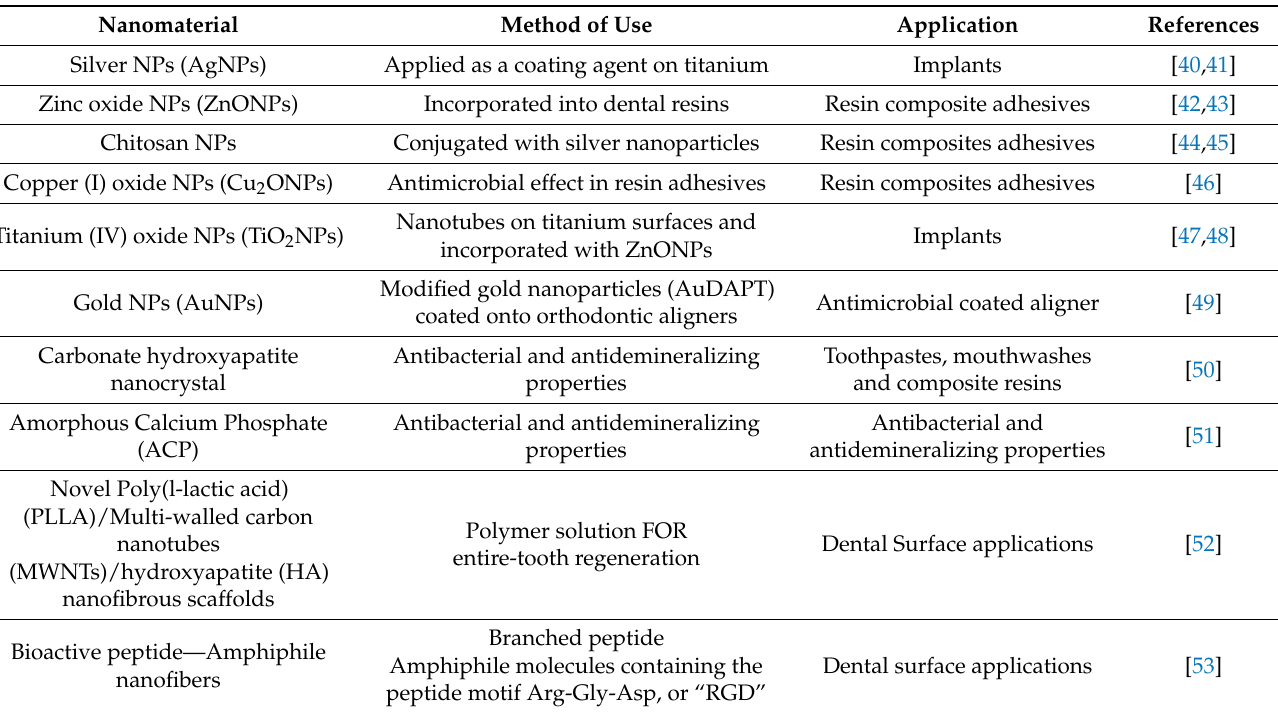
Table 1. Nanomaterials application in